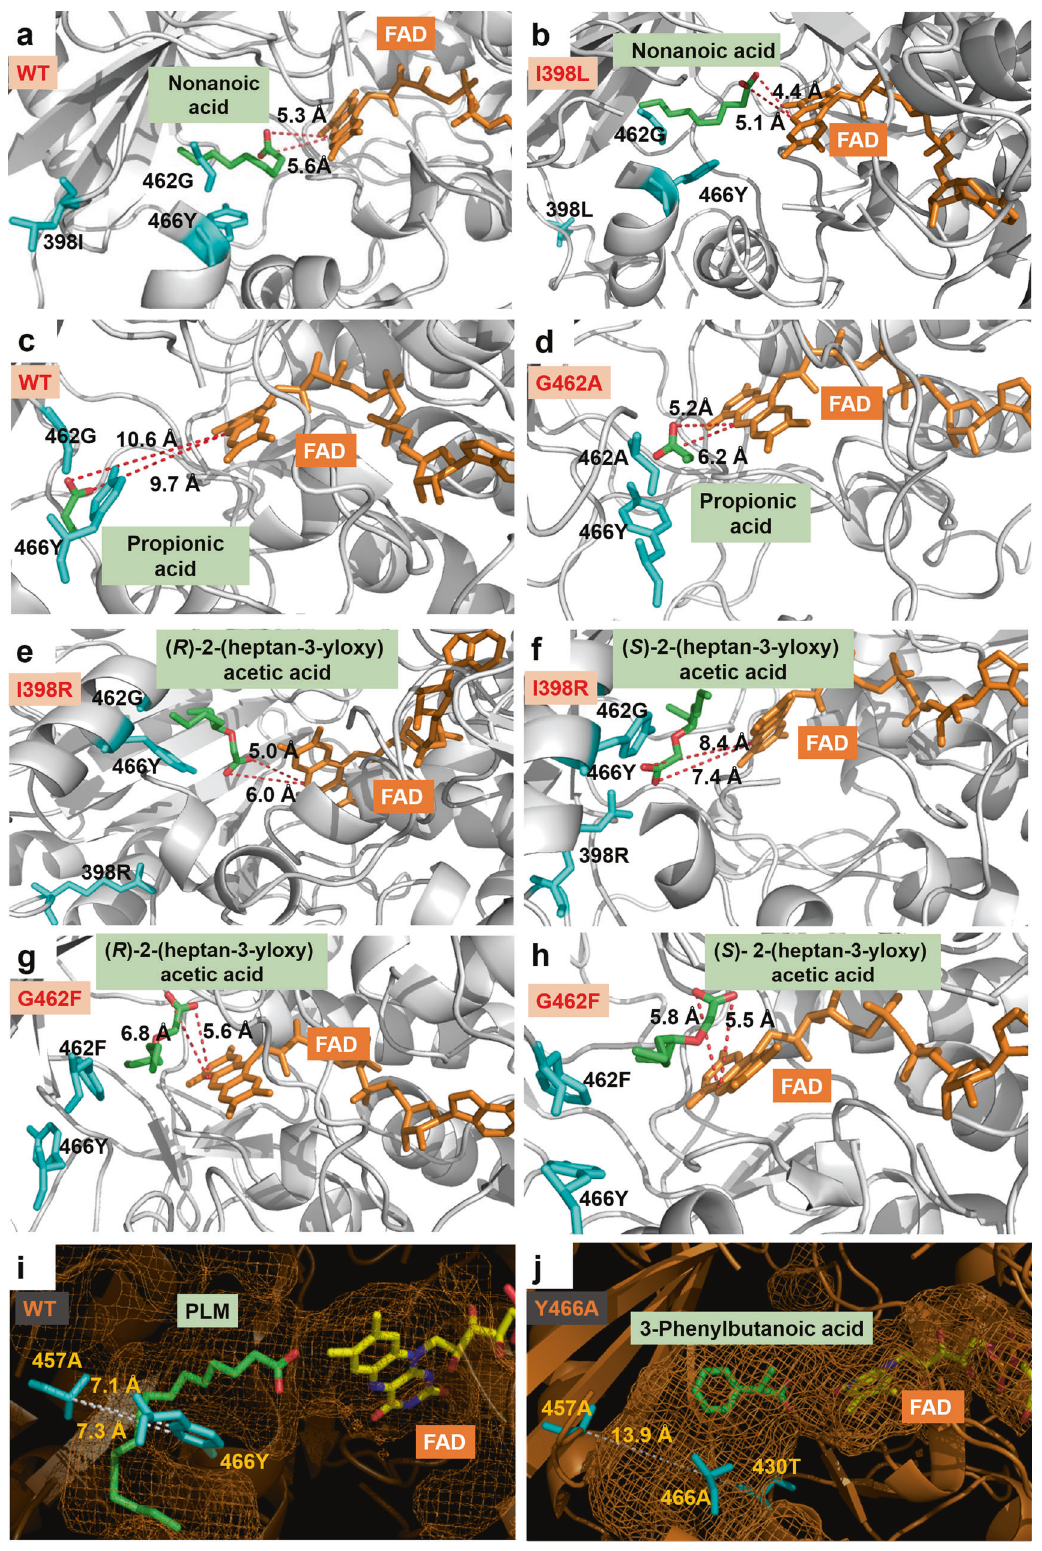
Fig. 7 MD simulations for gaining insight into the origins of the improved activity and stereoselectivity of Cv FAPs. a and b , for nonanoic acid. c and d , for butyric acid. e – h , for 2-(heptan-3-yloxy) acetic acid. i and j , the change of the binding tunnel ’ s diameter. The docked substrates (green), PLM (palmitic acid, green), FAD (yellow) and some important residues (cyan) are depicted as stick models.